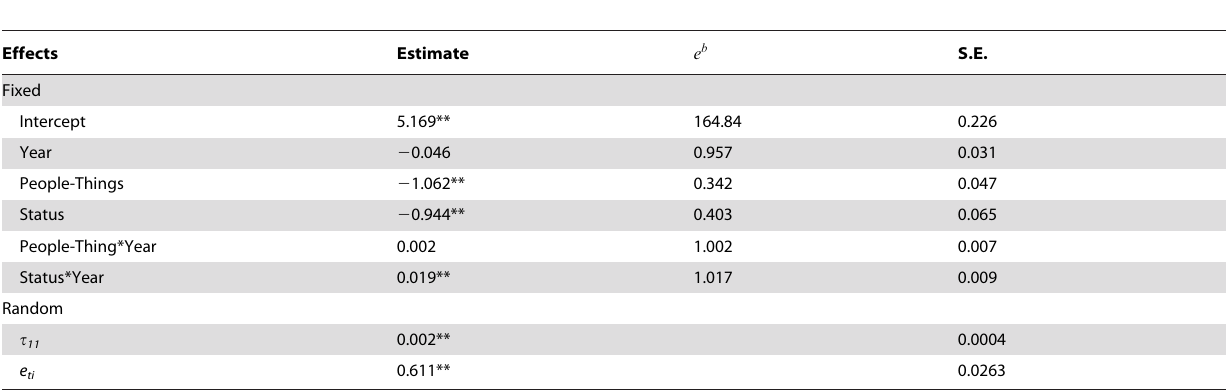
Table 3. Fixed and random effects of Model 2, which predicted the change in percent of women in an occupation from student ratings of occupations’ people-things orientation and status.